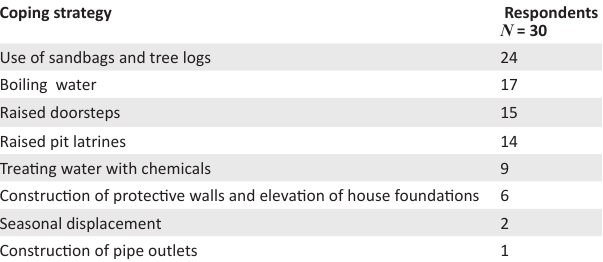
TABLE 3: Summary of household coping